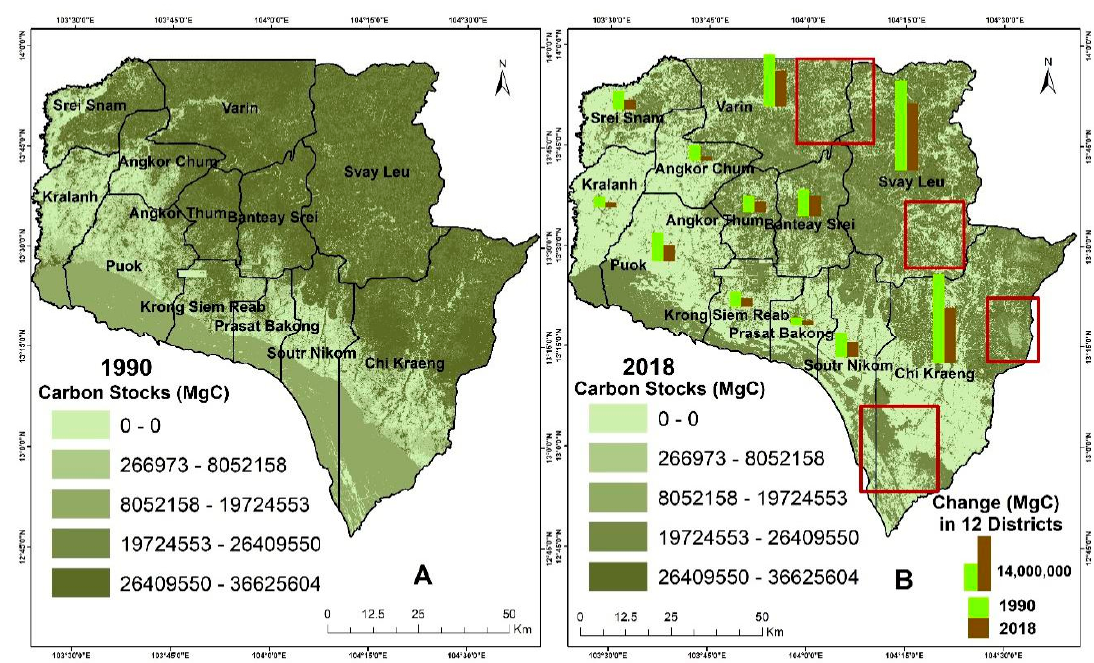
Figure 7. Carbon stock in 1990 and 2018 in Siem Reap province. ( A ) Map of spatial carbon stock (MgC) concentrations in 1990 and ( B ) map showing the spatial carbon stock concentrations in 2018. The red boxes indicate the larger changes of carbon stocks (MgC) in the region. Note: 0 (Mgc) falls within the non-forest areas including water and other land cover category. The graph on the map (Figure 7B) shows the carbon stock change from 1990 (light green color bars) to 2018 (dark brown color bars) and 14,000,000 is the scale of the bar graph. Table 7. Changes in forest carbon stocks by forest